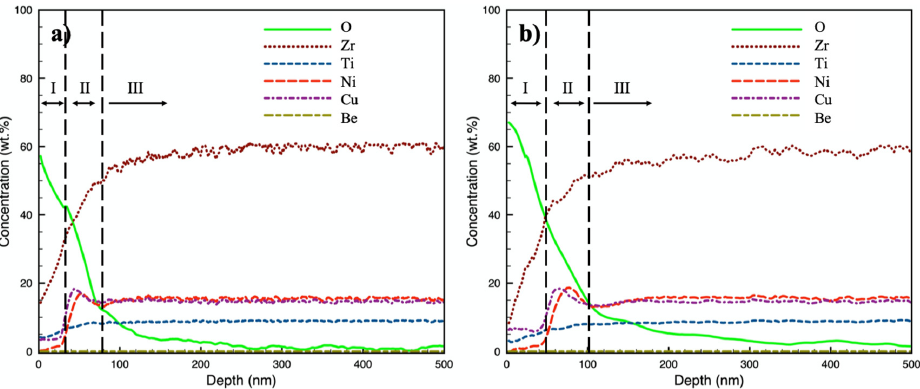
Figure 6. GDOES composition-depth profiles of ( a ) 350-40 and ( b ) 380-4.5; Profiles were plotted based